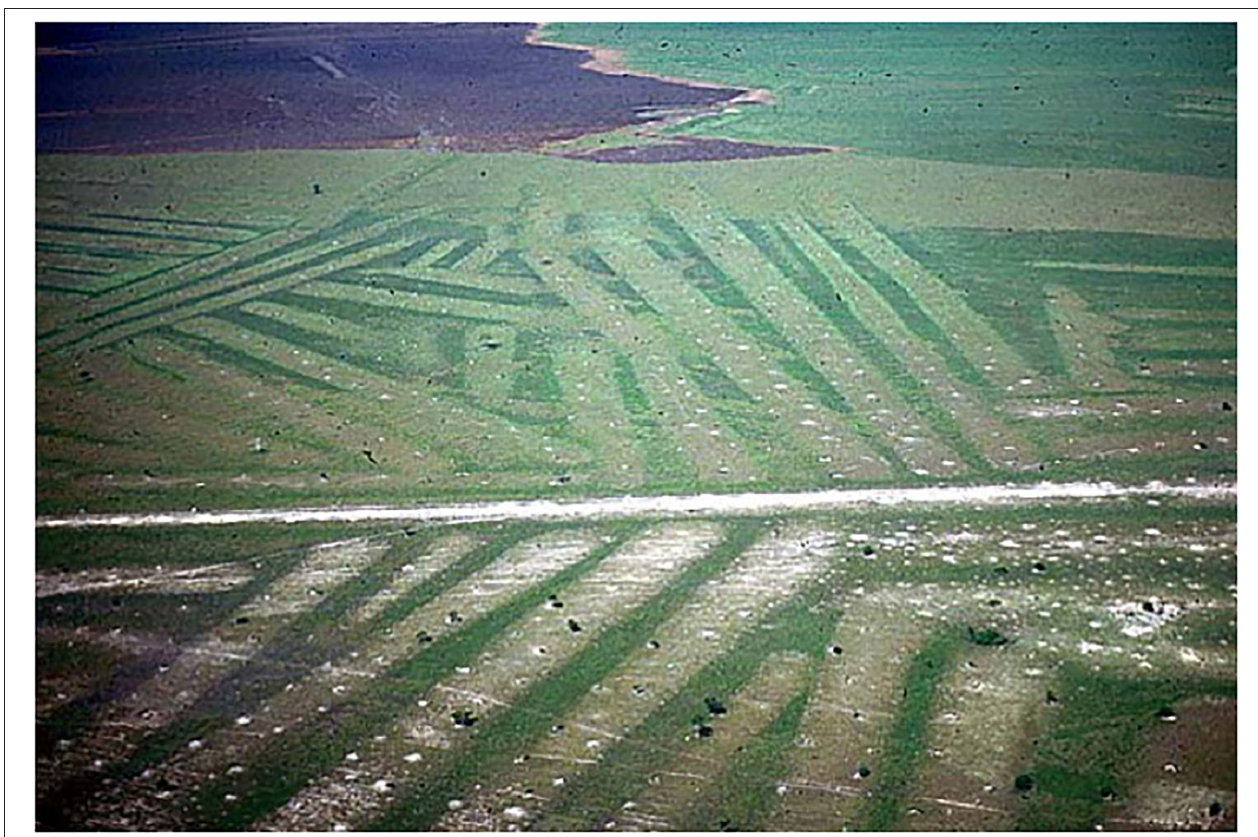
FIGURE 6 | An aerial LIDAR image of a portion of the Beni region of Bolivia that reveals the extent of the chinampas (raised agricultural fields) and the vast irrigation canals that today is hidden by a dense forest canopy. The Beni is about 78,000 km 2 of raised agricultural fields (chinampas) integrated with fishponds/canals ( Erickson, 2001; Mann, 2005, 2008; Heckenberger et al., 2008). Photograph by Clark Erickson, University of Pennsylvania. Reproduced with permission from the author (Clark